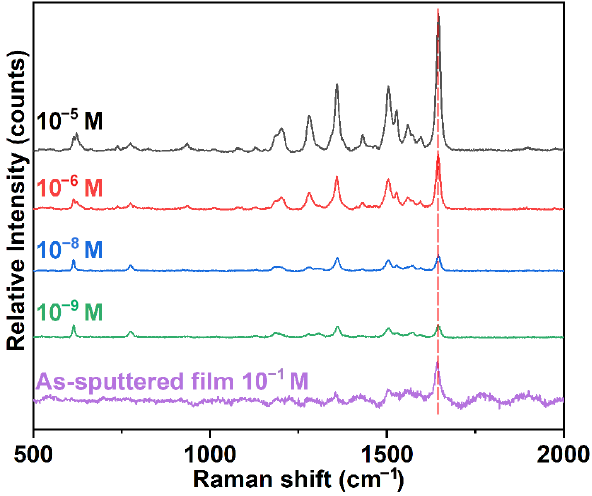
Figure 4. SERS spectra of RhB with different concentrations on the 3# sample and SERS diffractogram of RhB with 10 −1 mol/L RhB on the Au-Ag film. Table 3. EF of the 3# with different RhB concentrations.